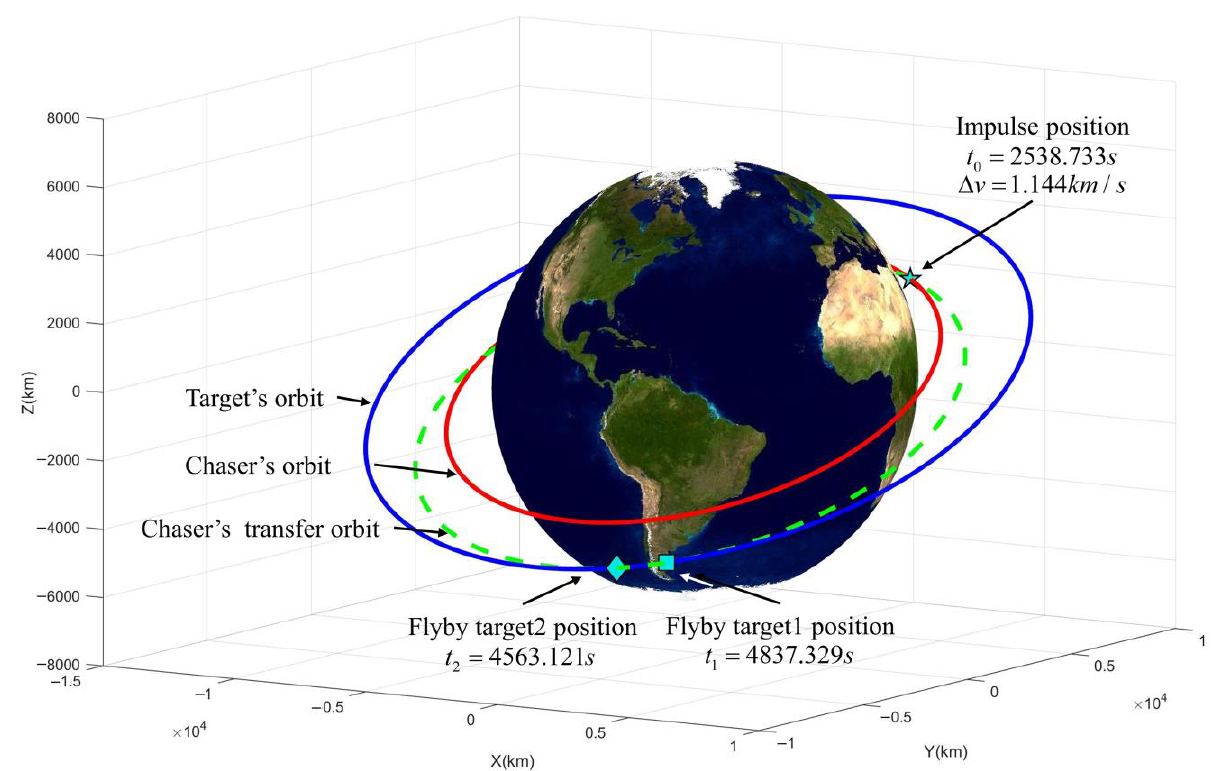
Figure 8. The minimum fuel solution of case 1.